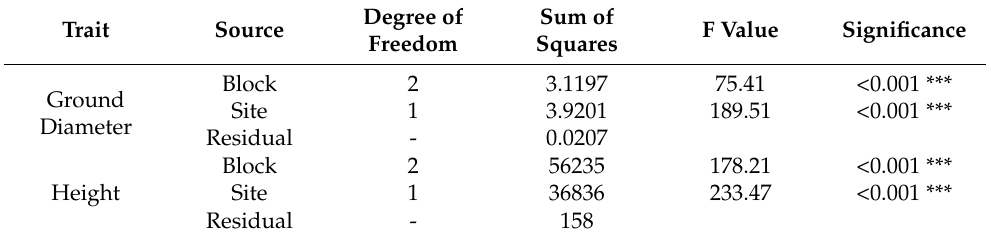
Table 5. Fixed-effects analysis. ‘***’ means extremely significant ( p < 0.01).